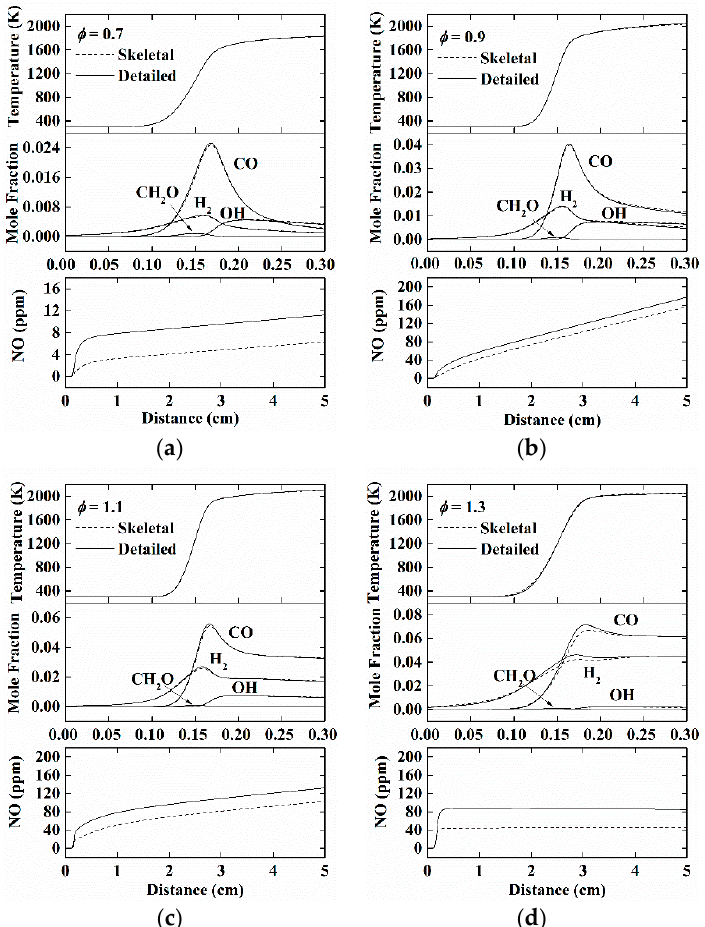
Figure 5. Critical intermediate components, temperatures, and distribution of pollutants in the case with the addition of 4000 ppm ozone. For cases, ( a ) ϕ = 0.7; ( b ) ϕ = 0.9; ( c ) ϕ = 1.1; ( d ) ϕ = 1.3.